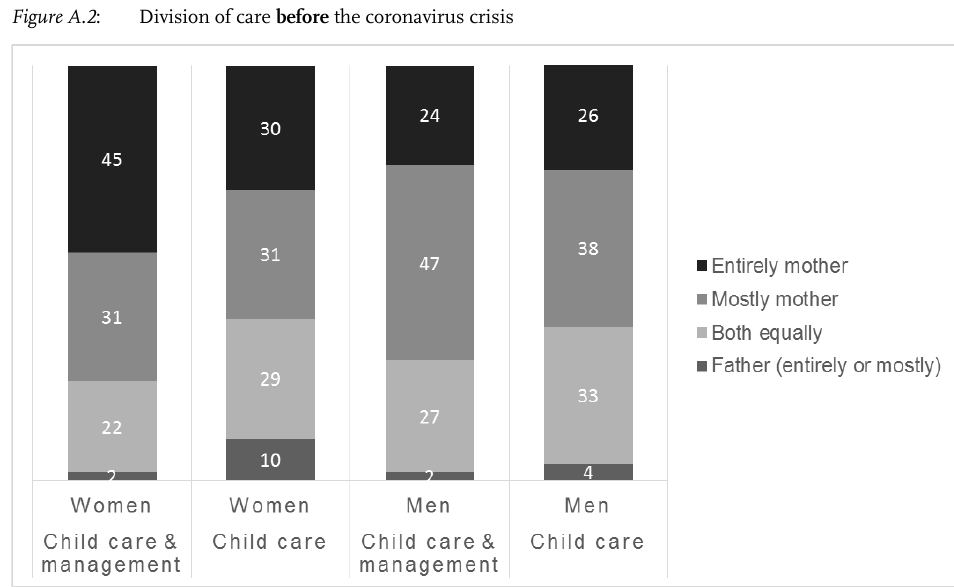
Figure A.2 : Division of care before the coronavirus